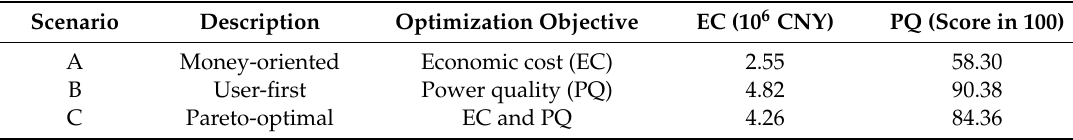
Table 3. Optimization results of three Figure 13. One noninferior solution of the Pareto frontier — power production/consumption (MW) in ME-VPP in 24 h.